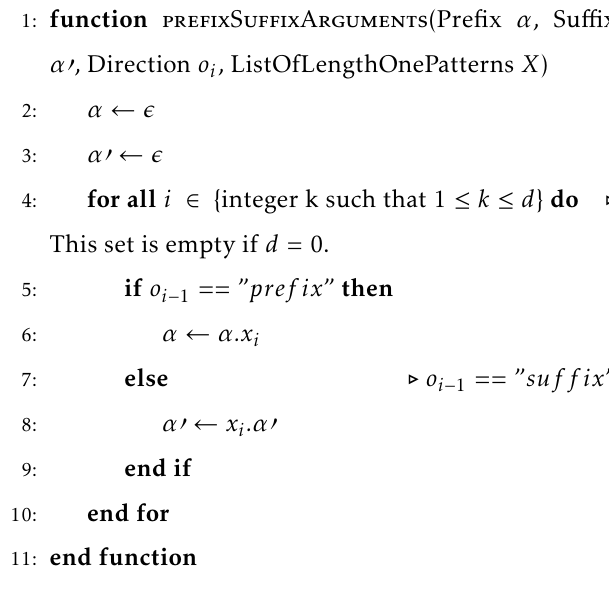
Algorithm 1 (prefixSu ffi xSpan) PrefixSu ffi x-growth sequential